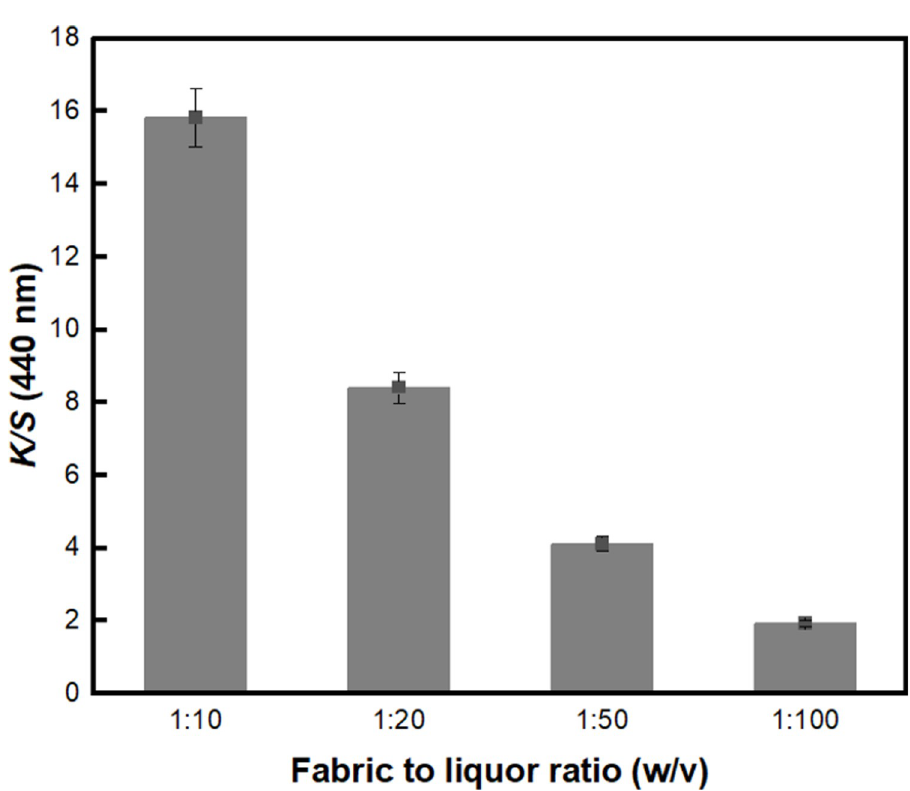
Fig 1. The K/S values of BC-COF bio-leather at 440 nm with varied extraction liquor ratios (Extraction conditions: Coffee at an amount of 200 wt% BC, 90˚C, 1 h; dyeing conditions: Fabric-to-liquor ratio of 1:10 (w/v), 70˚C, 30